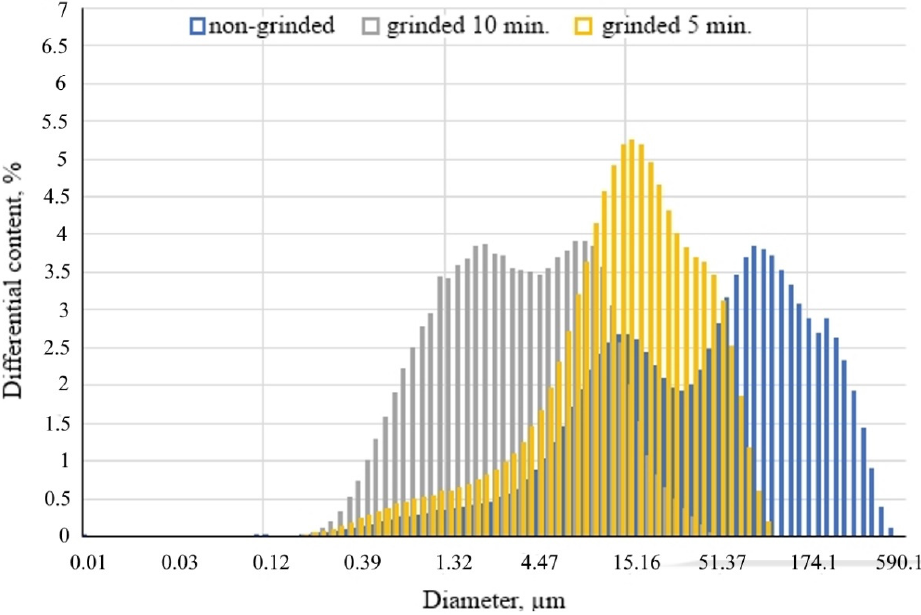
Figure 6. Particle size distribution of mineral wool production waste (TFM).